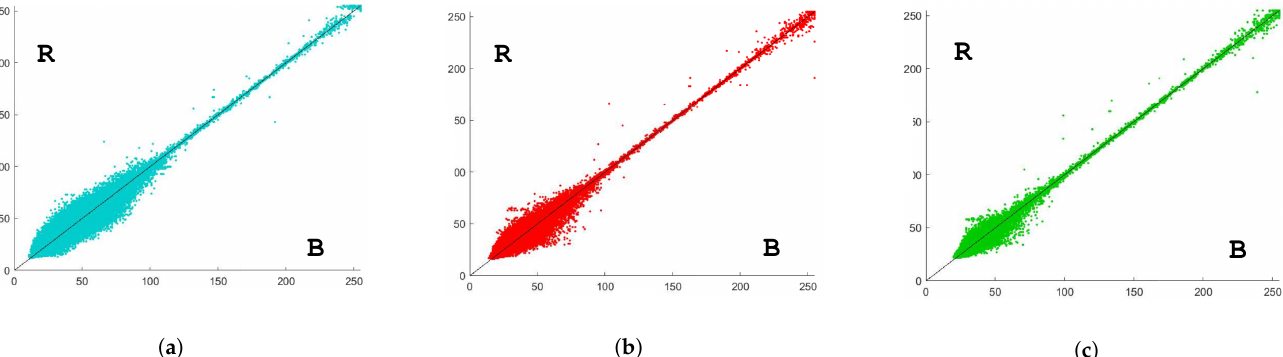
Figure 15. NRG self-validation test—ED based reconstruction; B = Base intensity values, R = Reconstructed intensity values. ( a ) scatter plot of near-infrared values; ( b ) scatter plot of red values; ( c ) scatter plot of green